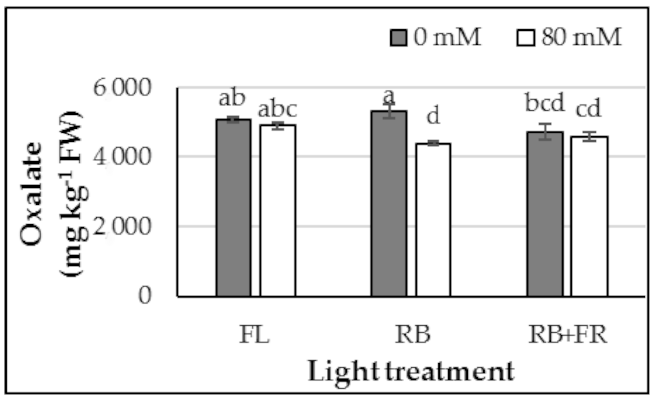
Figure 2. Effect of the different light (FL, RB and RB+FR) and salinity (0 and 80 mM NaCl) combina- tions on the oxalate content of purslane microgreens at harvest. Values are the mean ± SE (n = 9). Different letters indicate significant differences ( p ≤